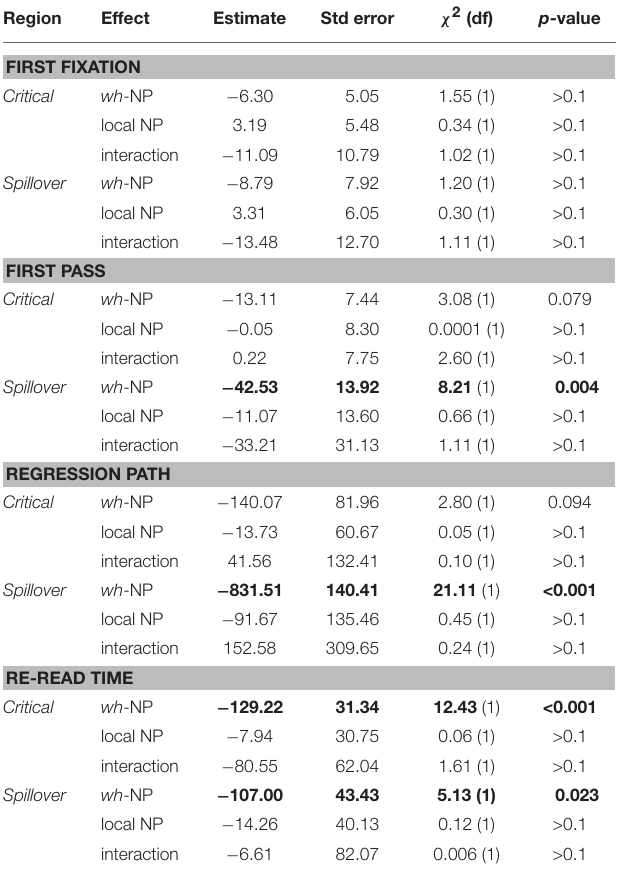
TABLE 4 | Combined ANOVA and LME results for Experiment 2. Region